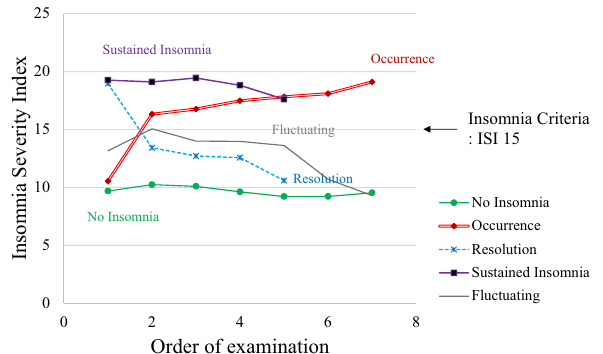
Figure 1. Insomnia patterns recorded during the study period. ISI Insomnia Severity Index.